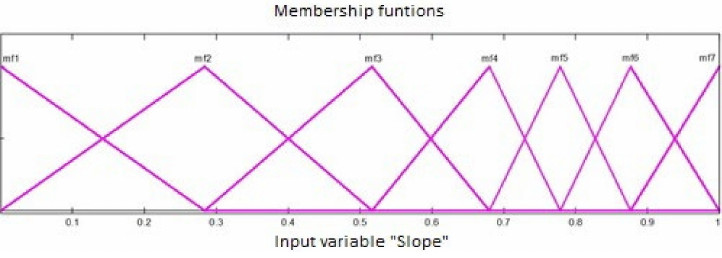
Figure 16. MFs of the input variable